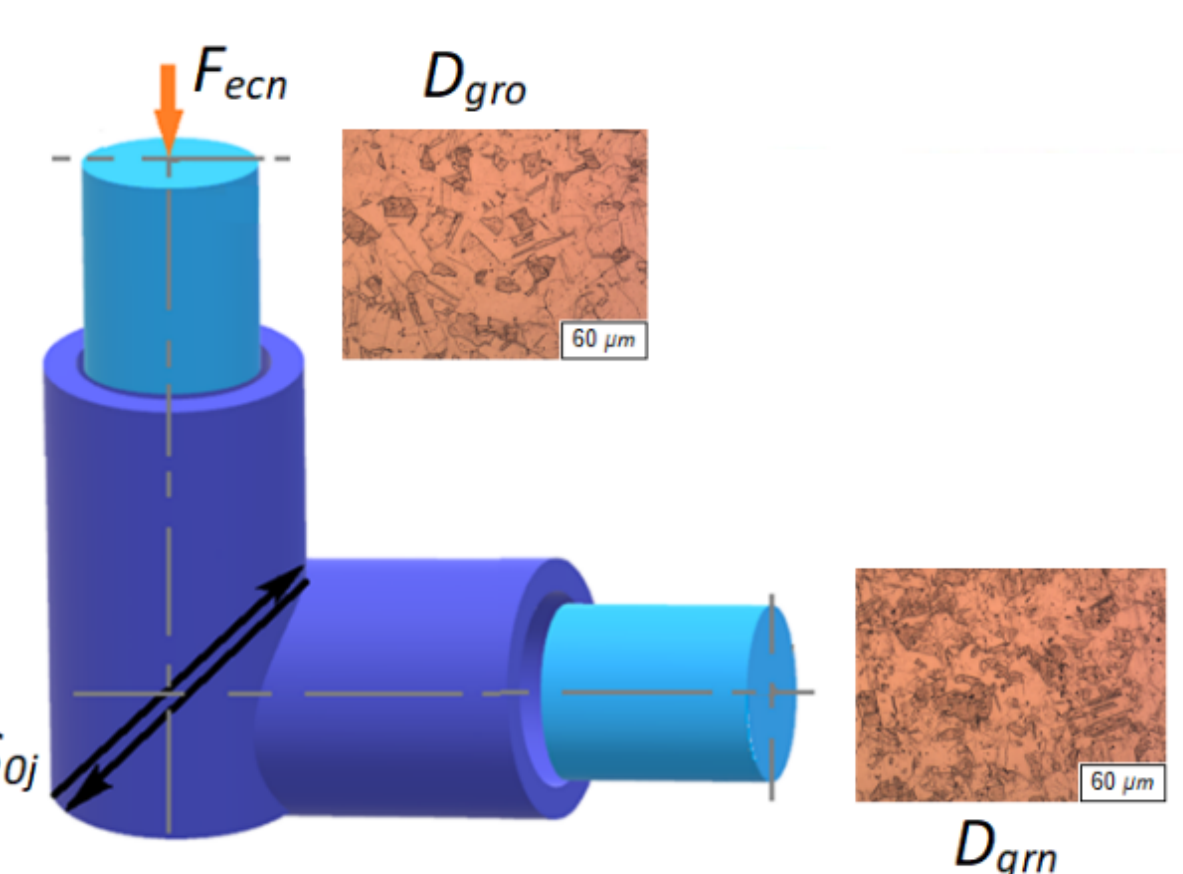
Figure 2. Principal scheme for the derivation of the equation.